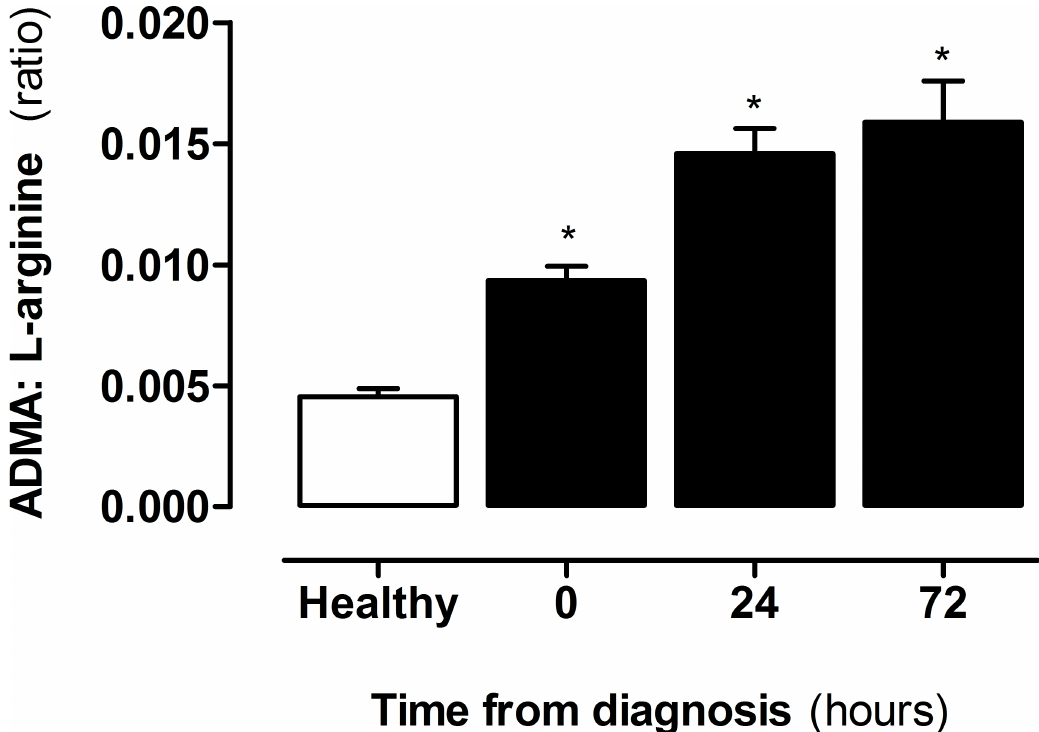
Fig 2. ADMA:L-arginine ratio in healthy donors vs patients with sepsis. ADMA and L-argininewere measuredfrom plasma of healthy donorsand patients with sepsis at diagnosis (0 hours), 24 and 72 hours post diagnosis using ELISA. Data are ± SEM for n = 21 healthy donorsand n = 38 patients with sepsis. Data was analysedby one-wayANOVA with Dunnett’s post-hoc test. * p < 0.05.